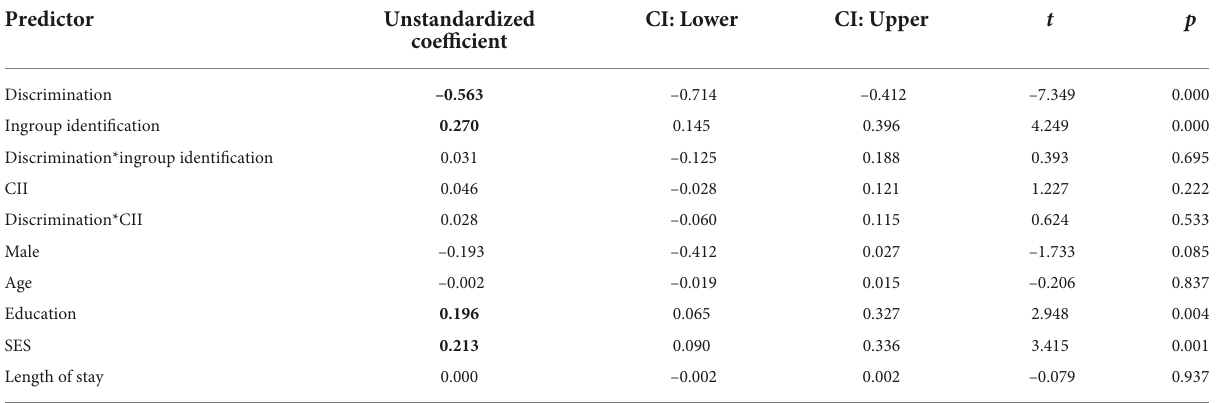
TABLE 3 Moderation analysis on wellbeing in South Korean